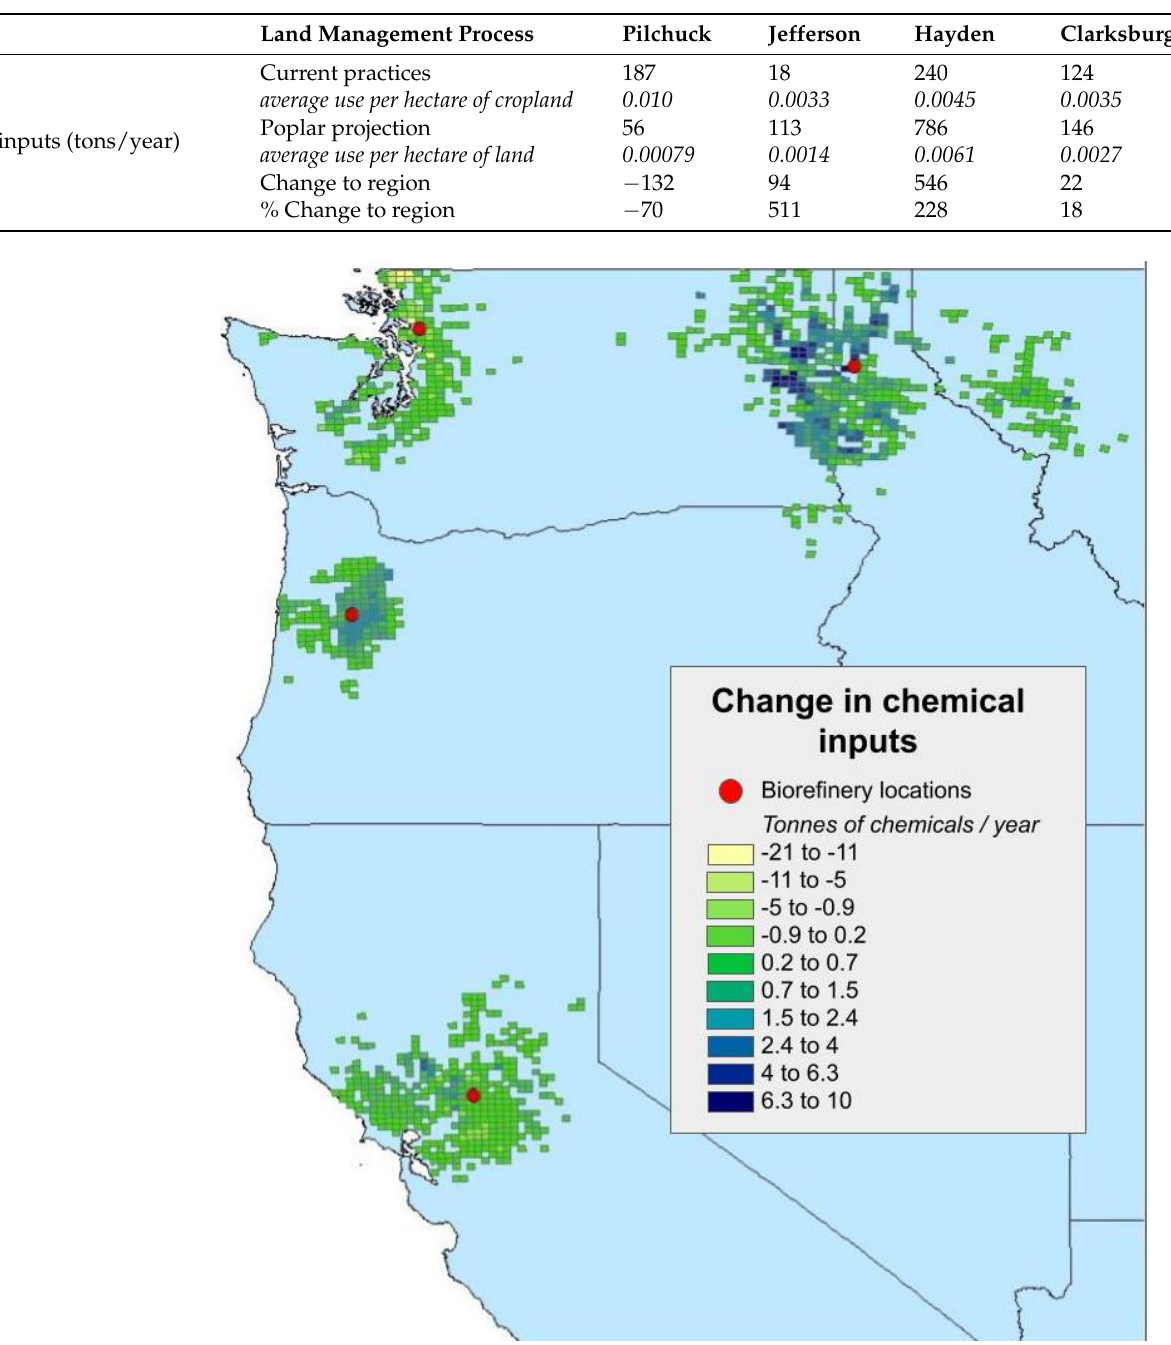
Table 7. Chemical pest control inputs. Average use of inputs per hectare of land for each region shown in italics.